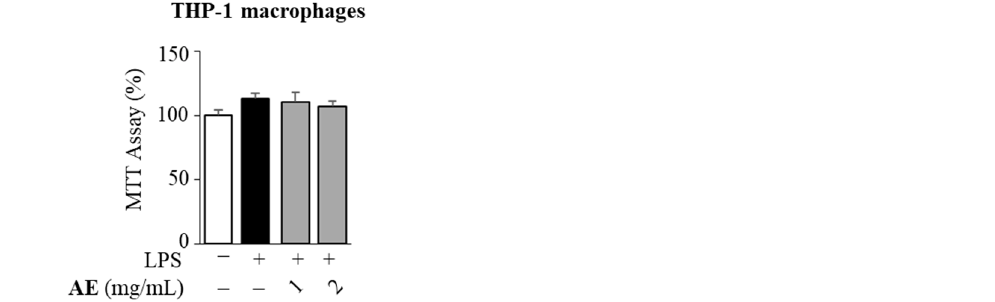
Figure 4. MTT (3-(4,5-Dimethylthiazol-2-yl)-2,5-Diphenyltetrazolium Bromide) growth in lipopolysaccharide (LPS)-stimulated THP-1 macrophages untreated ( − ) or treated for 24 h with 1 and 2 mg/mL of artichoke extract (AE). Cell viability is expressed as % of control ( − ). The value represents the means ± SEMs of three different experiments, each performed with triplicate samples.